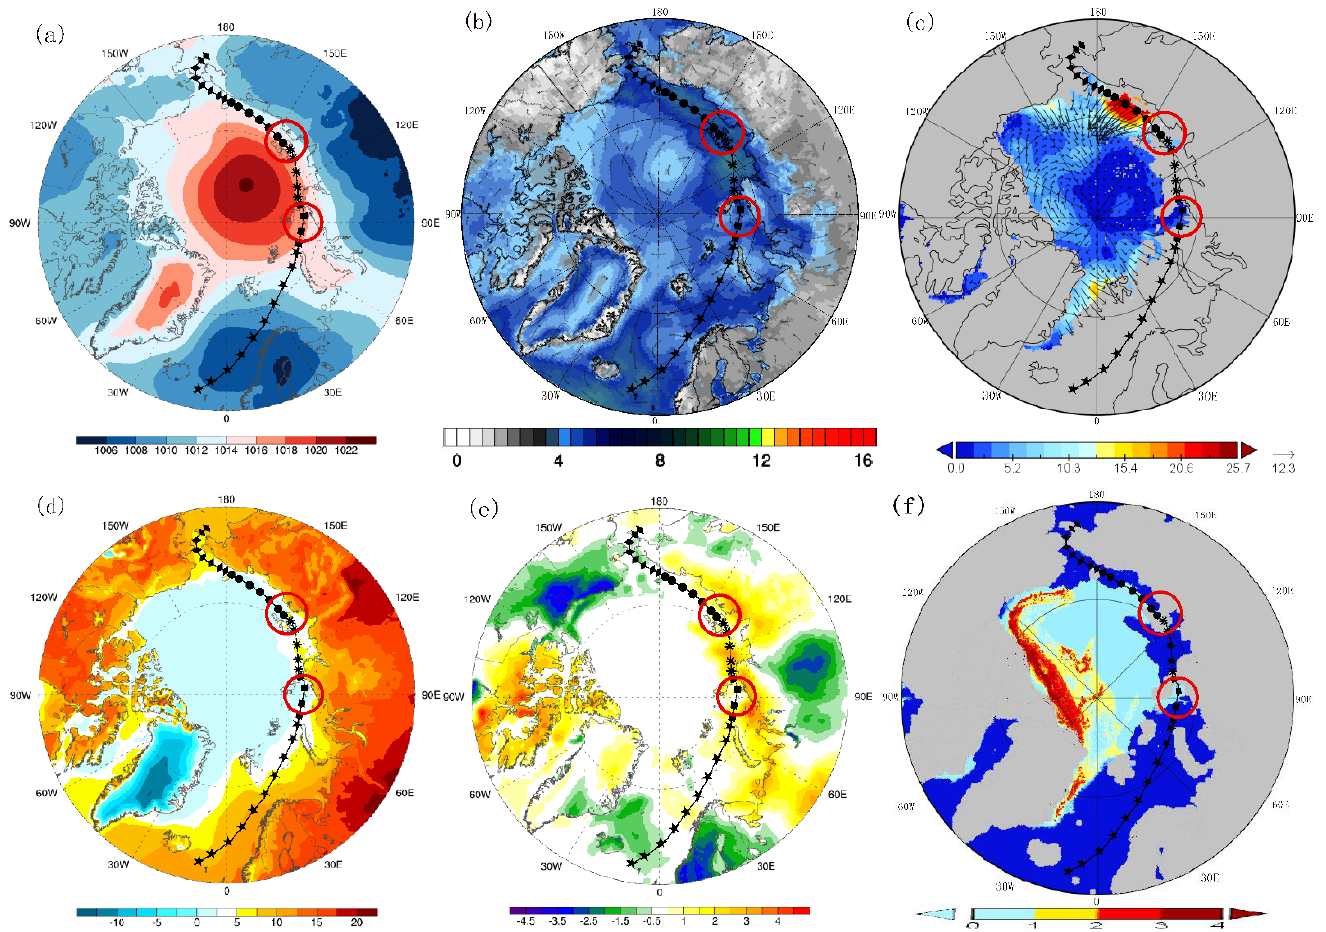
Figure 19. Distribution map of ( a ) sea level pressure (unit: hpa); ( b ) wind field (unit: m − 1 ); ( c ) sea ice movement (unit: m − 1 ); ( d ) temperature (unit: centigrades); ( e ) temperature anomaly (unit: centigrades) and ( f ) sea ice age (unit: year) in the Arctic summer in July 2020. (The red circles represent the special areas.)